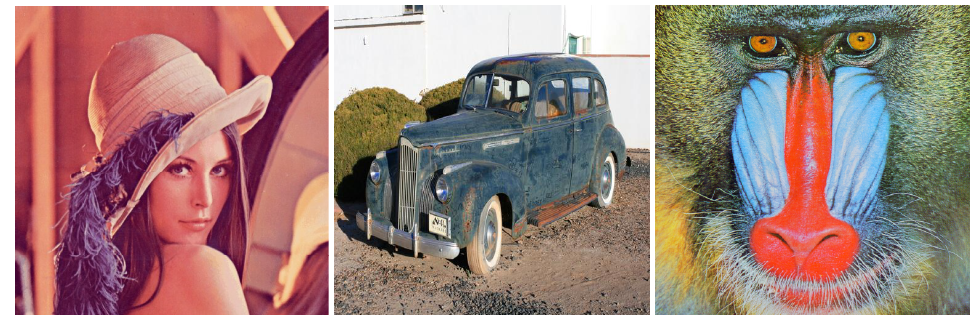
Figure 2. Data for evaluation: Lena, Car, and Baboon RGB images.